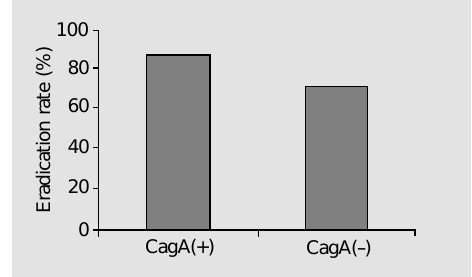
Figure 1. Eradication rates of the patients infected with cytotoxin- associated gene A (CagA)-posi- tive and -negative Helicobacter pylori strains. P = 0.019 (Fisher’s exact probability